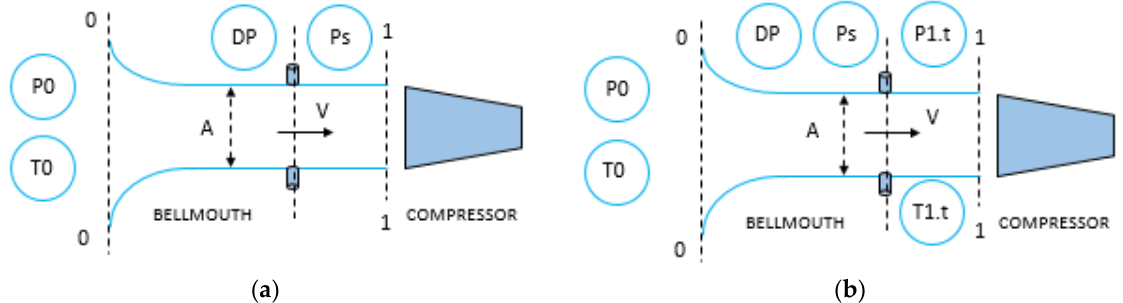
Figure 1. Bellmouth instrumentation method scheme, model ( a ), bellmouth instrumentation method scheme, model ( b ).